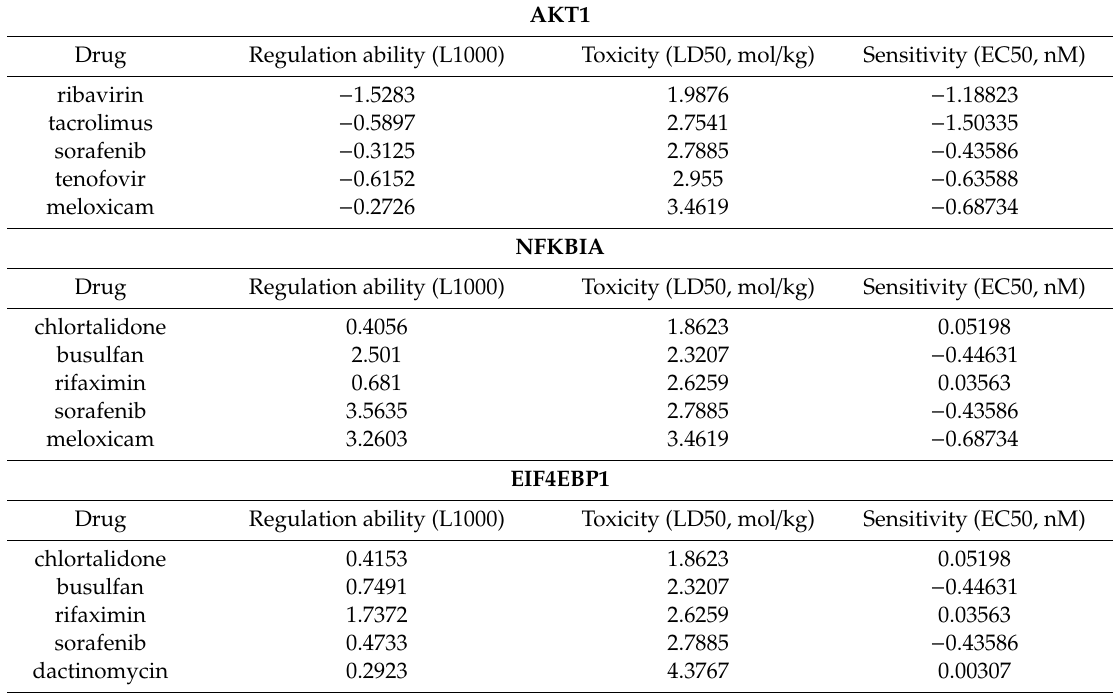
Table 6. The candidate multi-target drugs for the identified